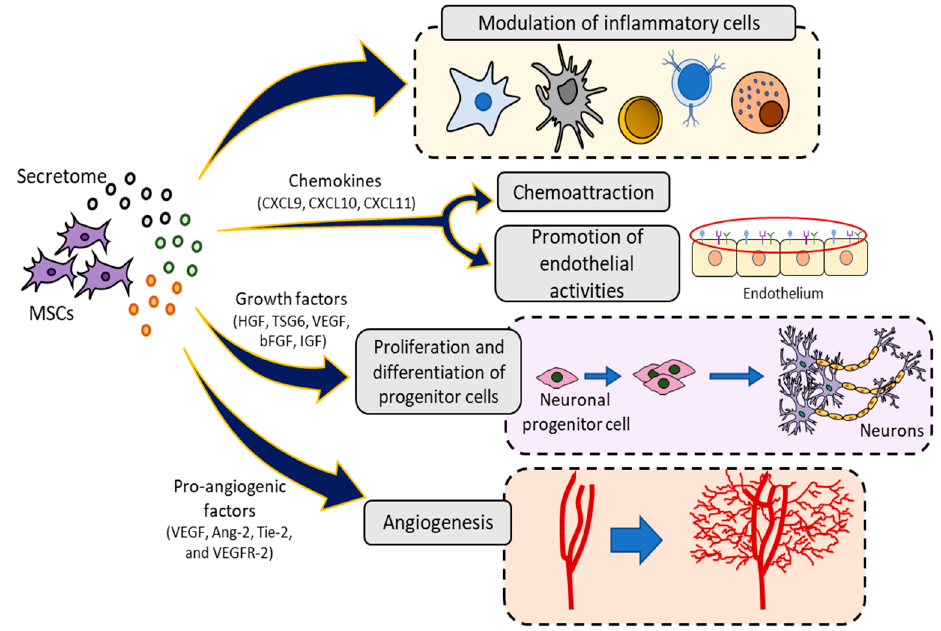
Figure 4. Paracrine activity of mesenchymal stromal cells (MSCs). MSC-secreted factors can interact directly at di ff erent cellular processes, such as immunomodulation, chemoattraction, progenitor cell proliferation, angiogenesis and di ff erentiation, remaining all of them essential to the correct function of MSCs within the body. HGF: hepatocyte growth factor; IGF: insulin-like growth factor 1; TSG6: tumor necrosis factor-inducible gene 6 protein; VEGF: vascular endothelial growth